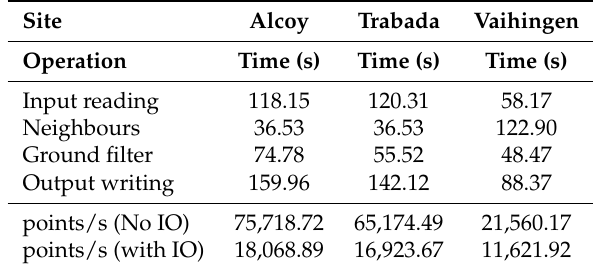
Table 4. Execution times and throughput in the Zedboard for the Alcoy (6 million points), Trabada (6 million points), and Vaihingen (3.77 million points) data with and without considering input and output